Question: Describe this figure in one sentence.
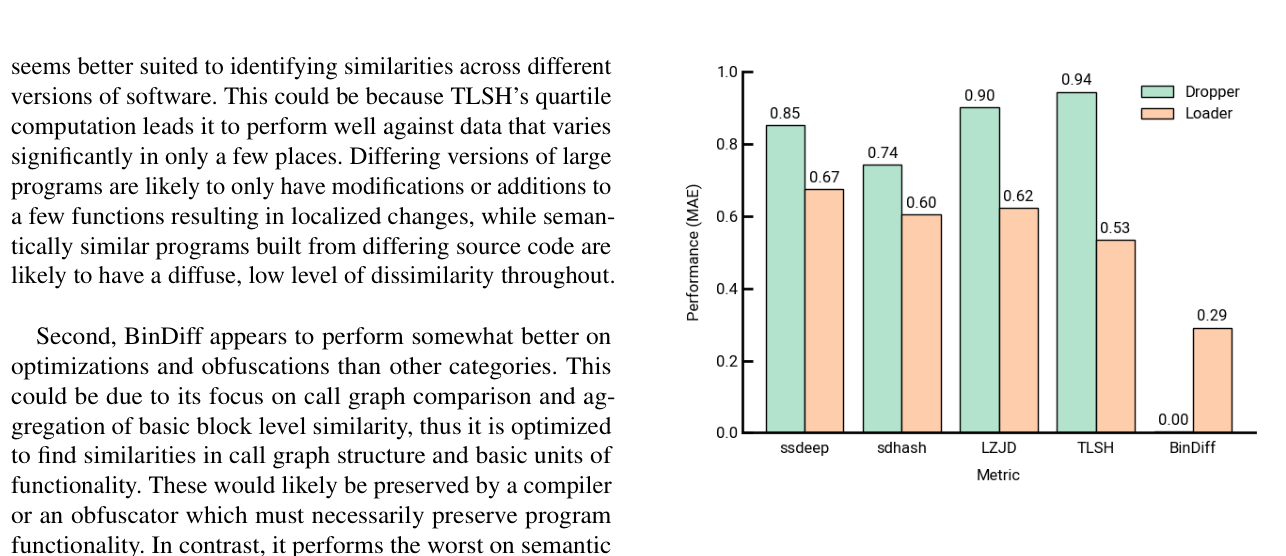
Answer: Program similarity metric performance on Cos- micDuke malware samples by sample category - lower is better.